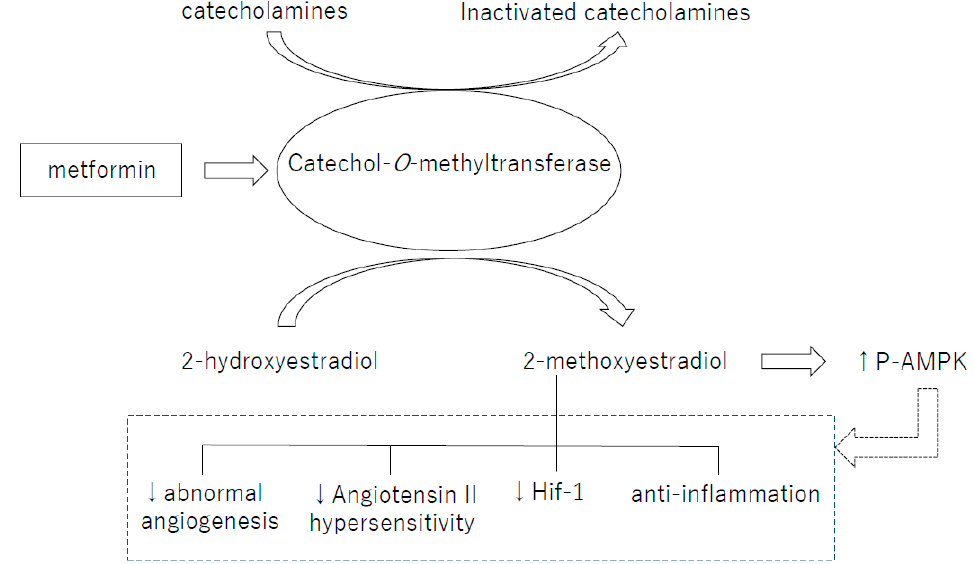
Figure 1. Catechol- O -methyltransferase (COMT) is an essential enzyme for the production of 2-methoxyestradiol (2-ME). 2-ME, a metabolite of COMT, induces activation of various molecular pathways, including activation of AMPK. ↑ : Increase in activity. ↓ : Decrease in activity.